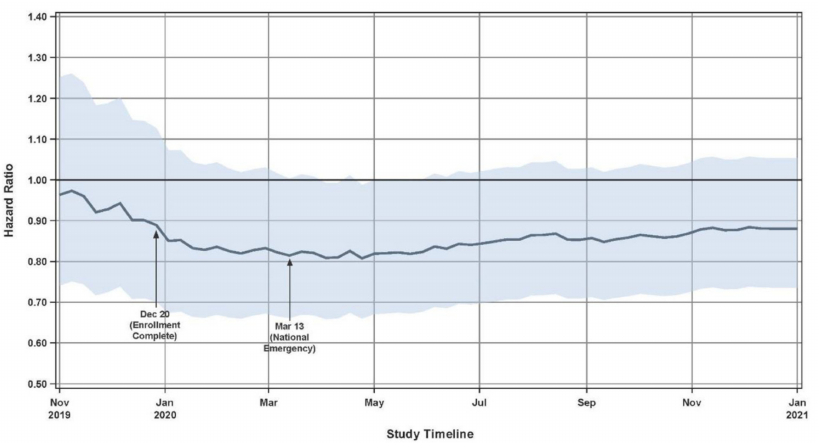
Figure 2. Primary endpoint hazard ratio and confidence interval evaluated over time in GUIDE-HF. Solid line reflects hazard ratio for data through each timepoint, shaded region reflects 95% confidence interval for each timepoint. Reprinted from The Lancet Volume 398, Issue 10304, Lindenfeld et al., Haemodynamic-guided management of heart failure (GUIDE-HF): a randomised controlled trial, pages 991–1001, Copyright 2021, with permission from Elsevier